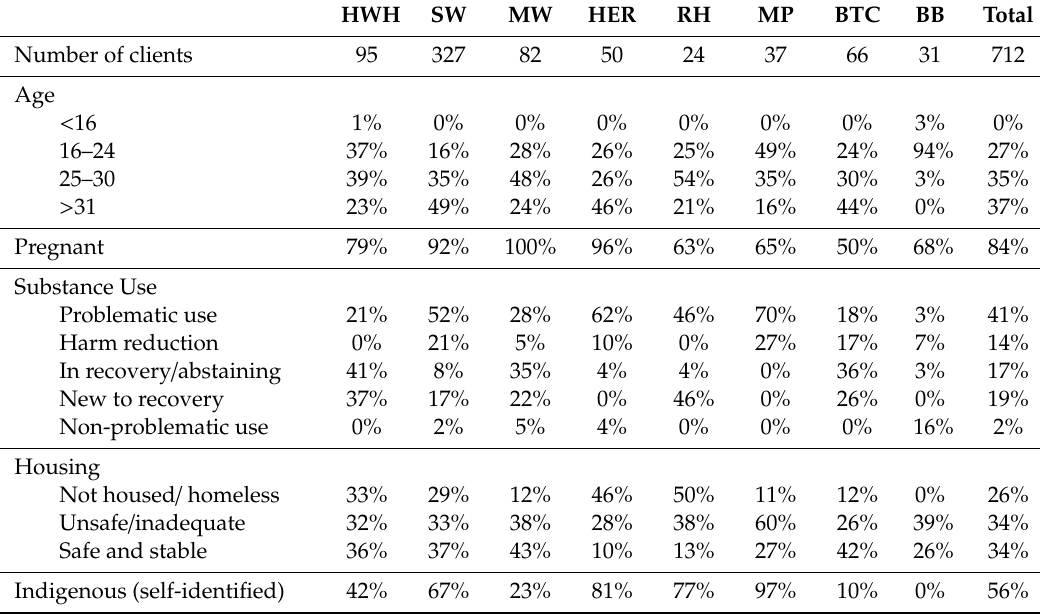
Table 2. Client characteristics by program site, at